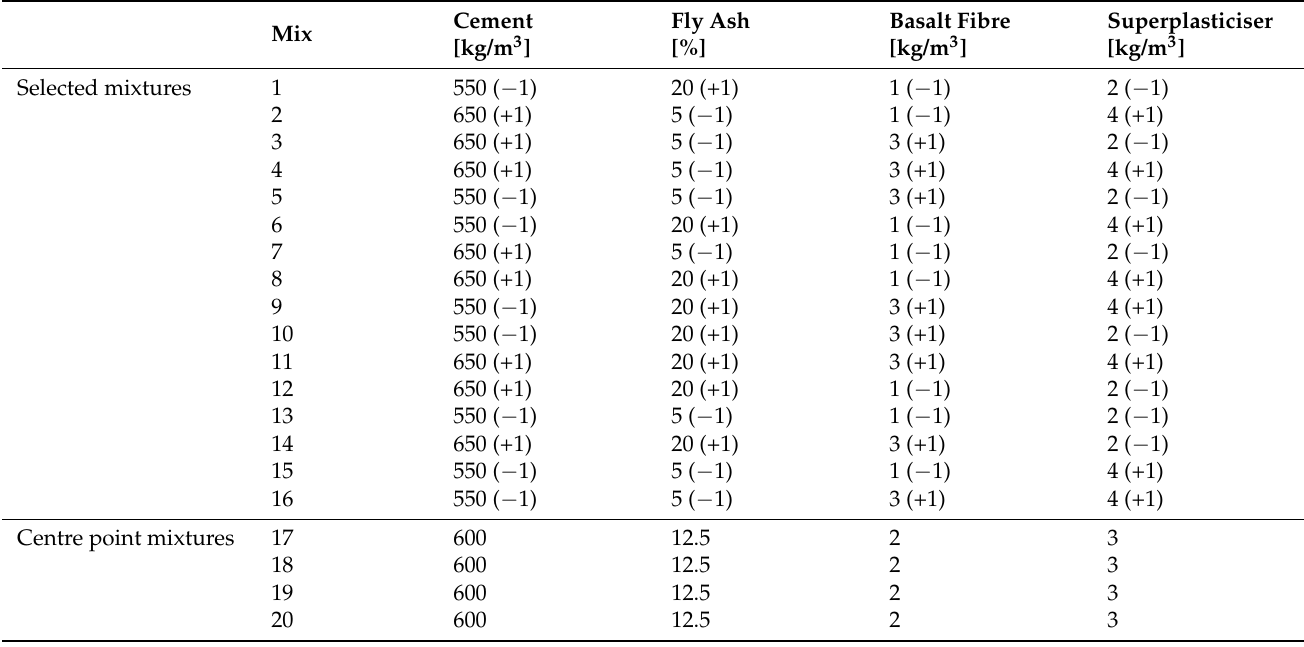
Table 4. Mix proportions of mortar (with coded